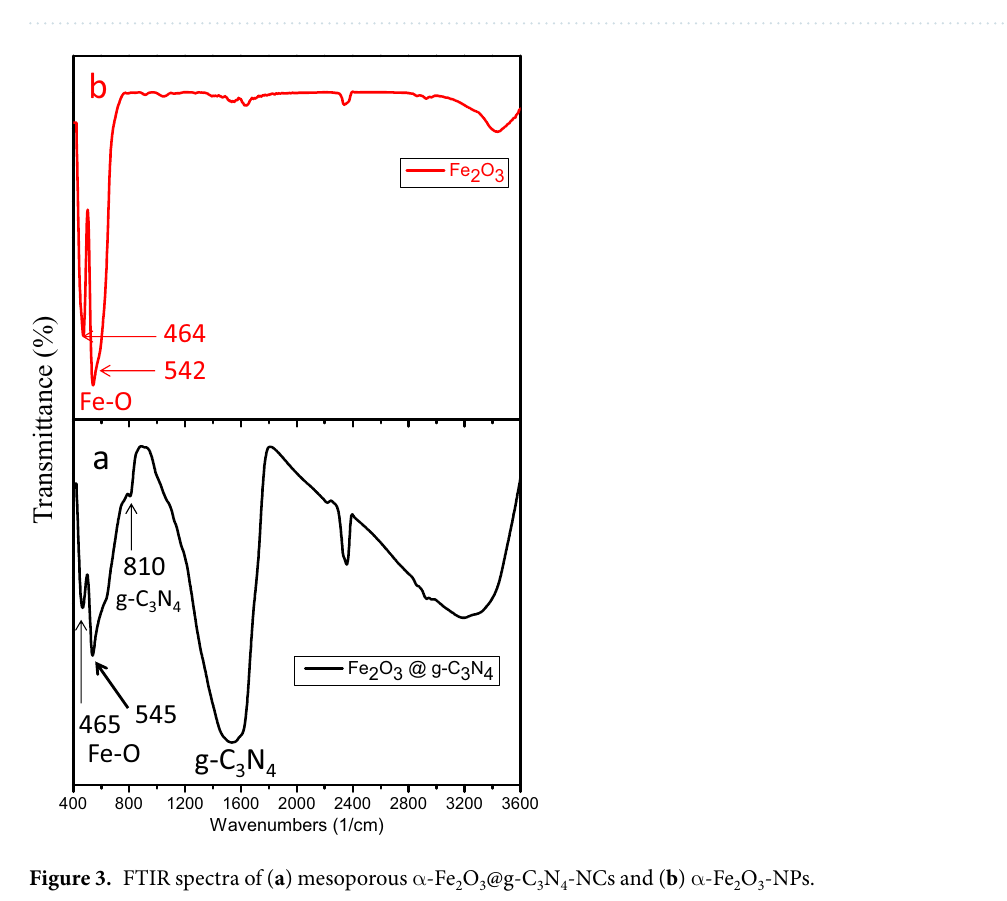
Figure 2. Full length XPS spectrum of mesoporous α -Fe 2 O 3 @g-C 3 N 4 -NCs and high resolution XPS spectra of N and Fe.